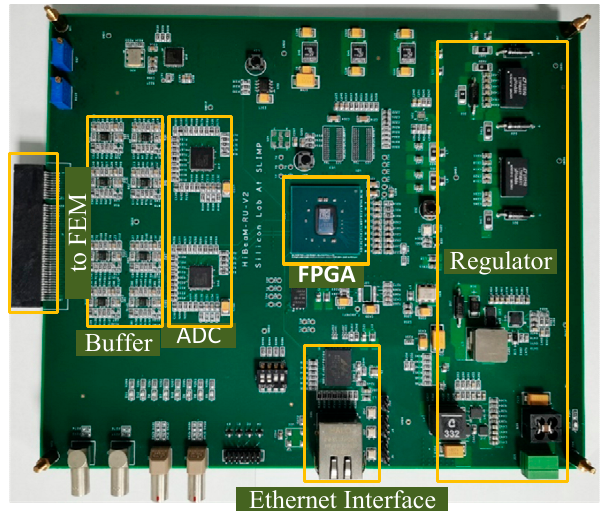
Figure 6. The picture of the RCM.